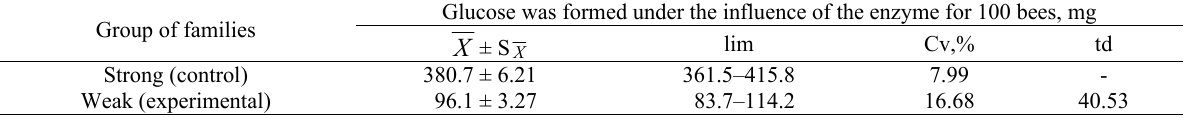
Inverting ability of bee glands during honey gathering from white acacia, n = 3 Glucose was formed under the influence of the enzyme for 100 bees, mg Group of families X ± S X lim Cv,% Strong (control) Weak